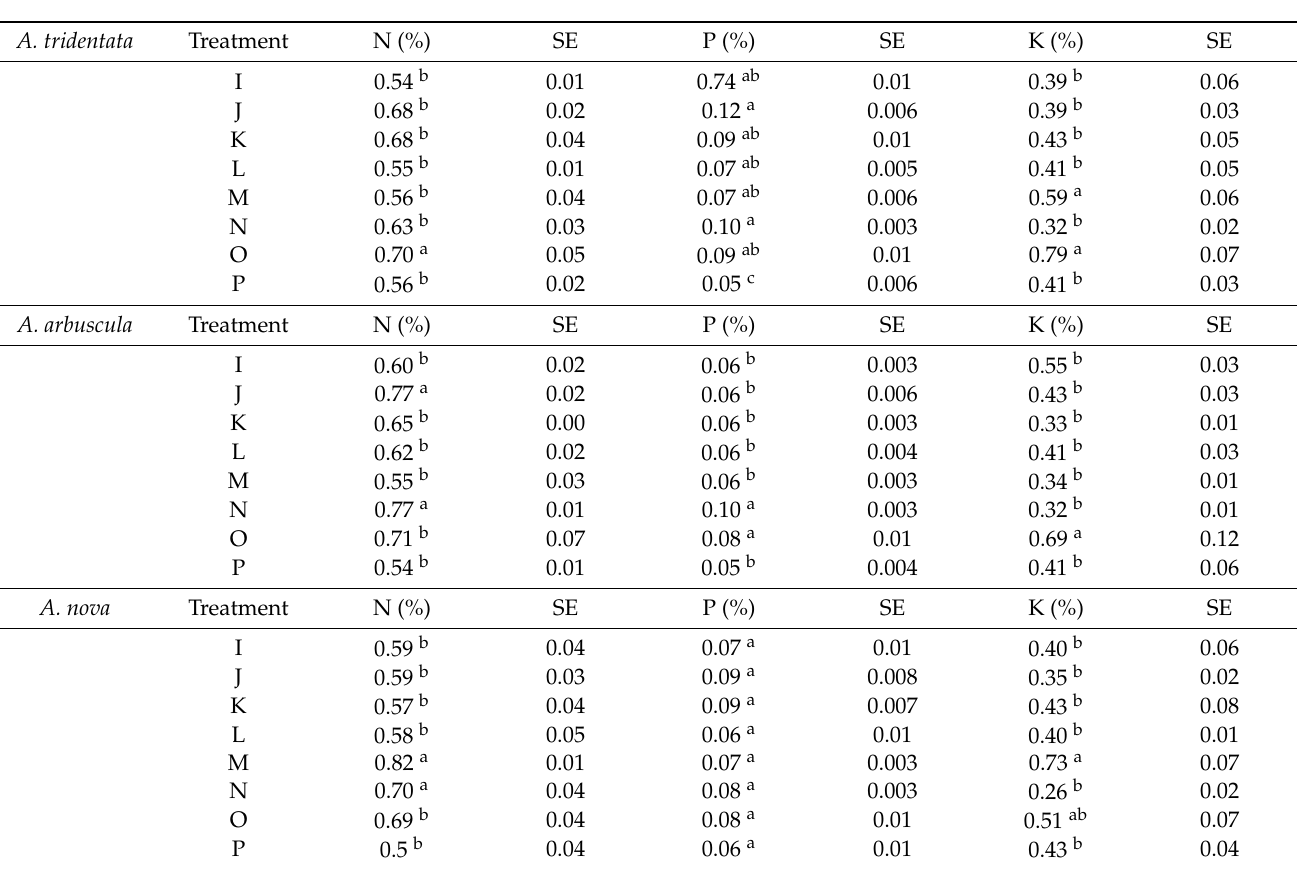
Table 4. Mean N, P, and K concentration ± SE in Taeniatherum caput-medusae grown for 6 months in different soil, moisture, inoculum treatments, and Artemisia species. Different letters in each column indicate significant differences among treatments (Tukey’s